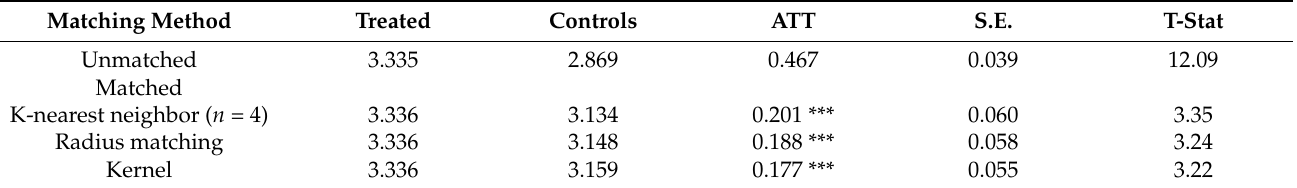
Table 5. Propensity score matching (PSM) estimation for the effect of Internet use on self-rated health.